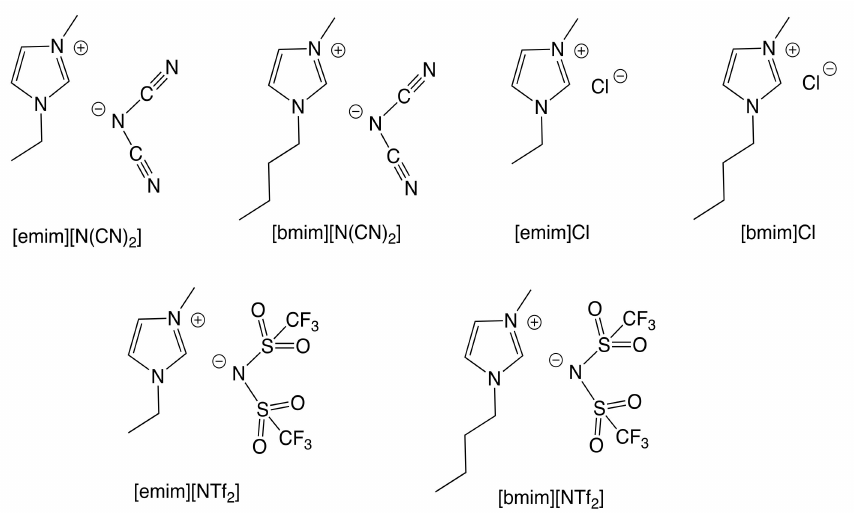
Figure 2. Room-temperature ionic liquids used in this work.